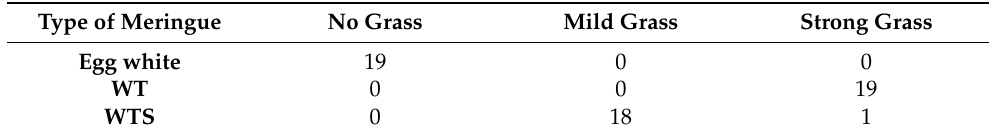
Table 7. Number of focus group participants detecting the taste of grass in the meringues produced with different protein